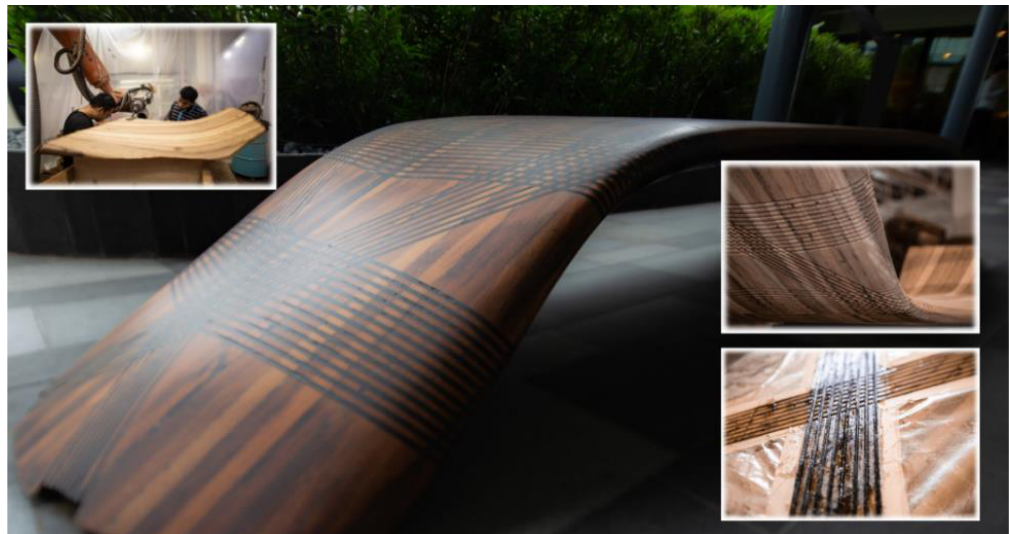
Figure 10. Application of the reinforcement mechanism onto a carbon fiber-reinforced timber bench.